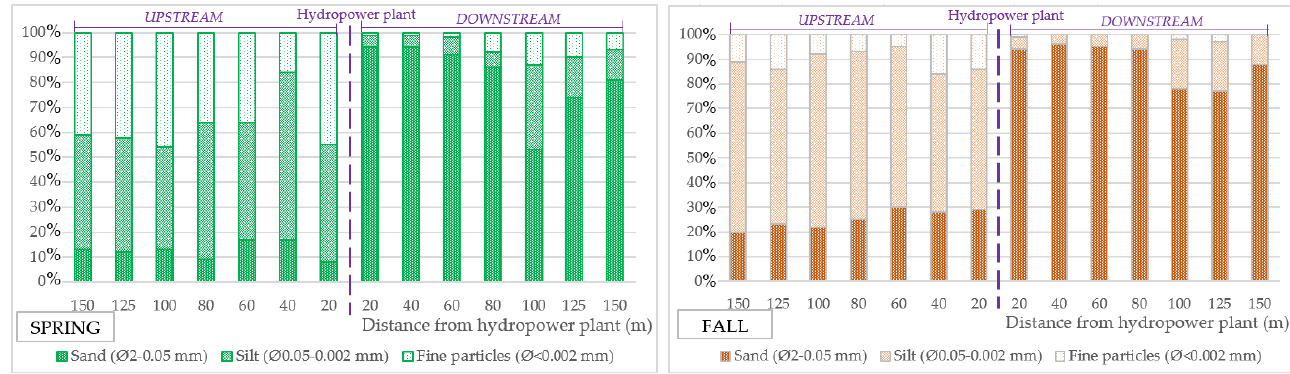
Figure 4. The percentage ratio of sand, silt, and fine particles (clay) in the investigated sediment near the hydroelectric power plant on the Ślęza River.